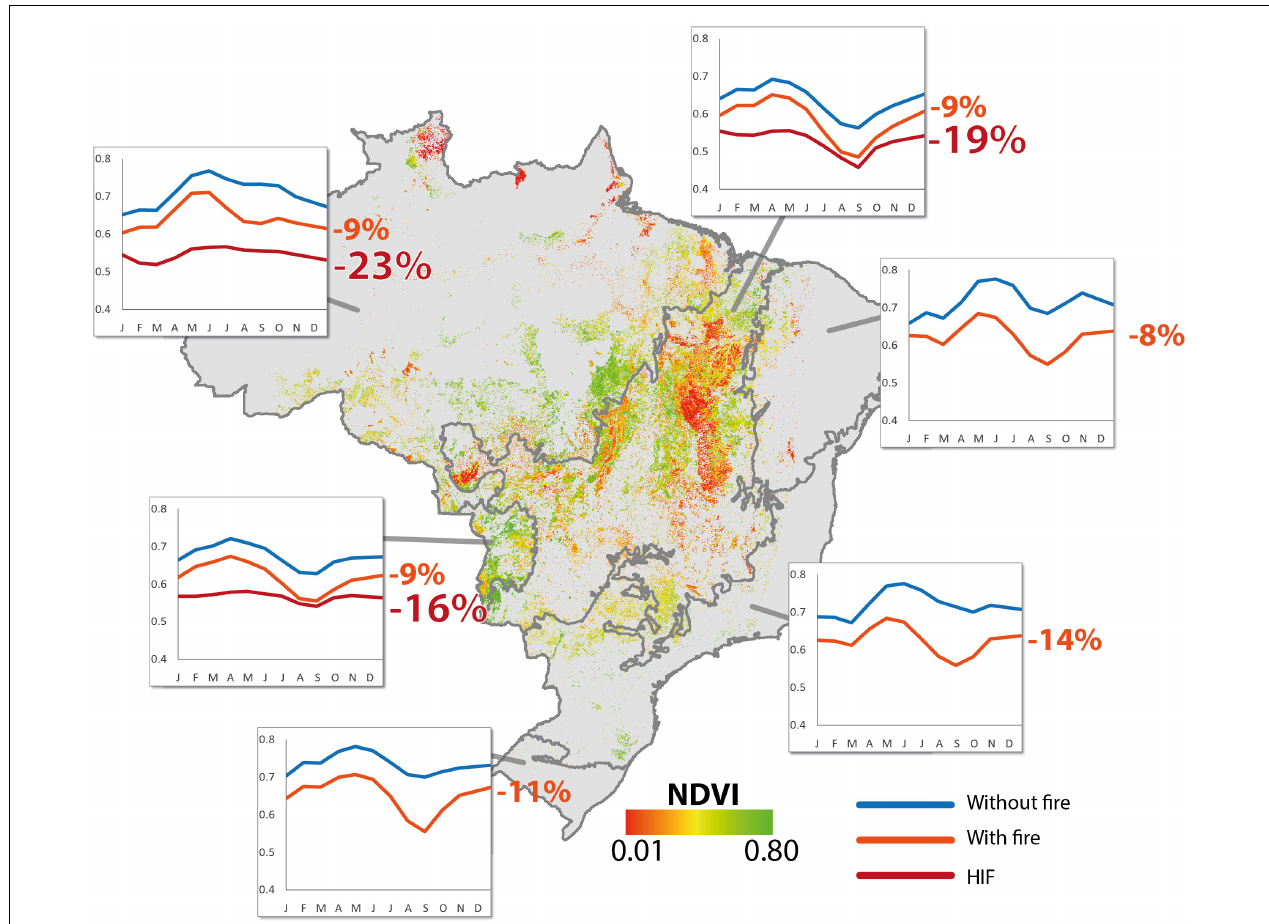
FIGURE 2 | Photosynthetic activity (NDVI) in areas that burned at least once. The graphs show the monthly mean NDVI between 2001 and 2019 for nun-burned areas, burned areas and HIF along with the respective reductions from the first.